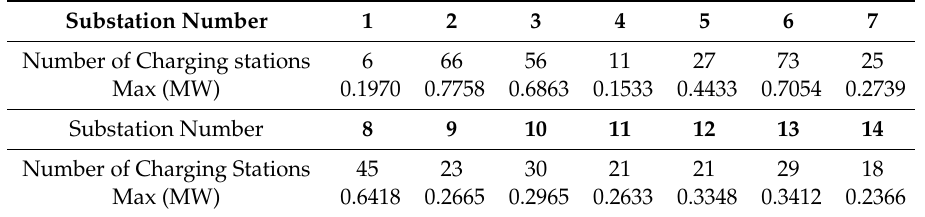
Table 1. Electric vehicle (EV) charging demand data from classified substations in Jeju Island.